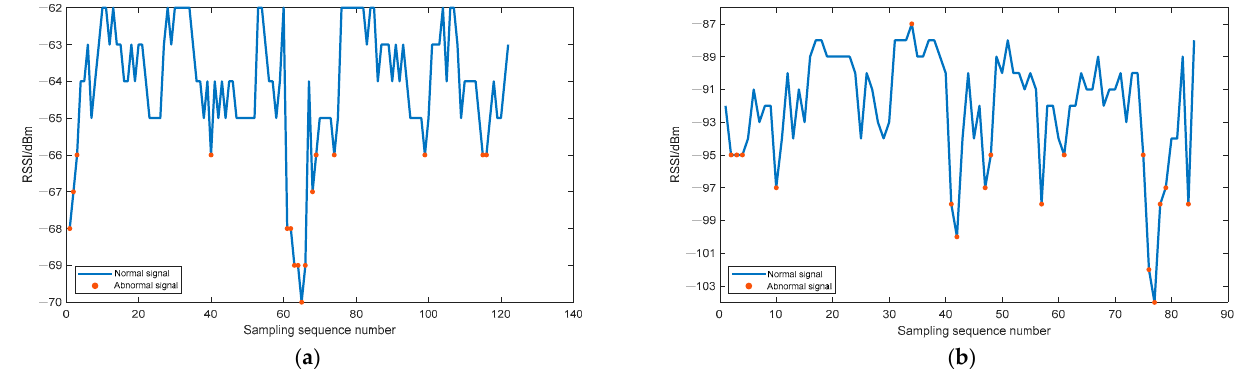
Figure 4. Model fitting.